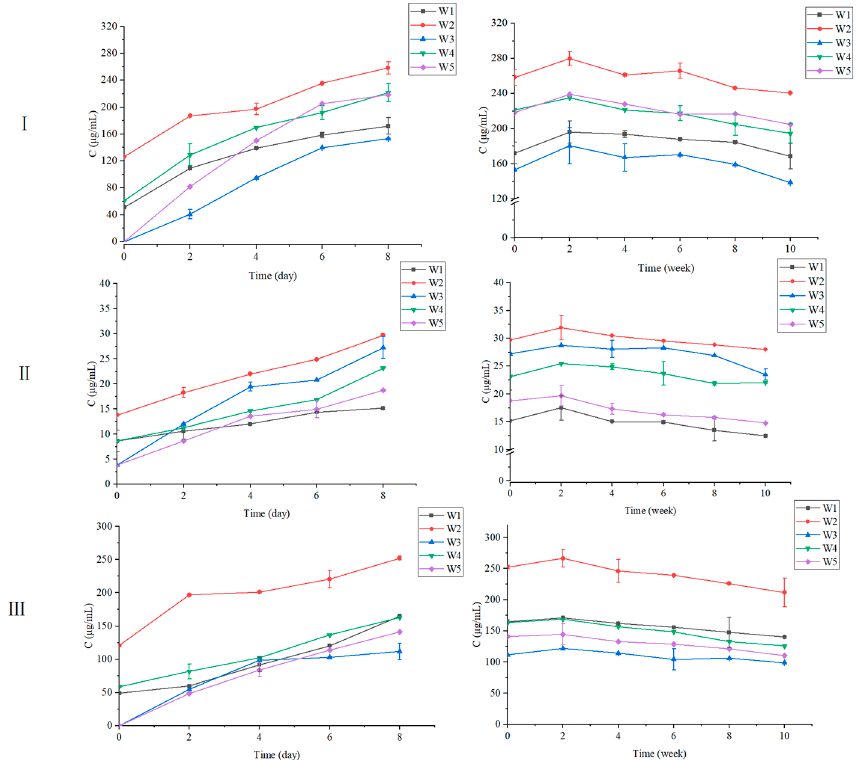
Figure 2. Variation in the contents of the major anthocyanins in black chokeberry wines during alcoholic fermentation period (left graph) and maturation period (right graph). ( I ). Cyanidin-3- O -galactoside, ( II ). Cyanidin-3- O -glucoside, ( III ). Cyanidin-3- O -arabinoside. W1—wine made by traditional fermentation; W2—wine made by frozen fruit fermentation; W3—wine made by co-fermentation; W4—wine made by carbonic maceration; W5—wine made by co-carbonic